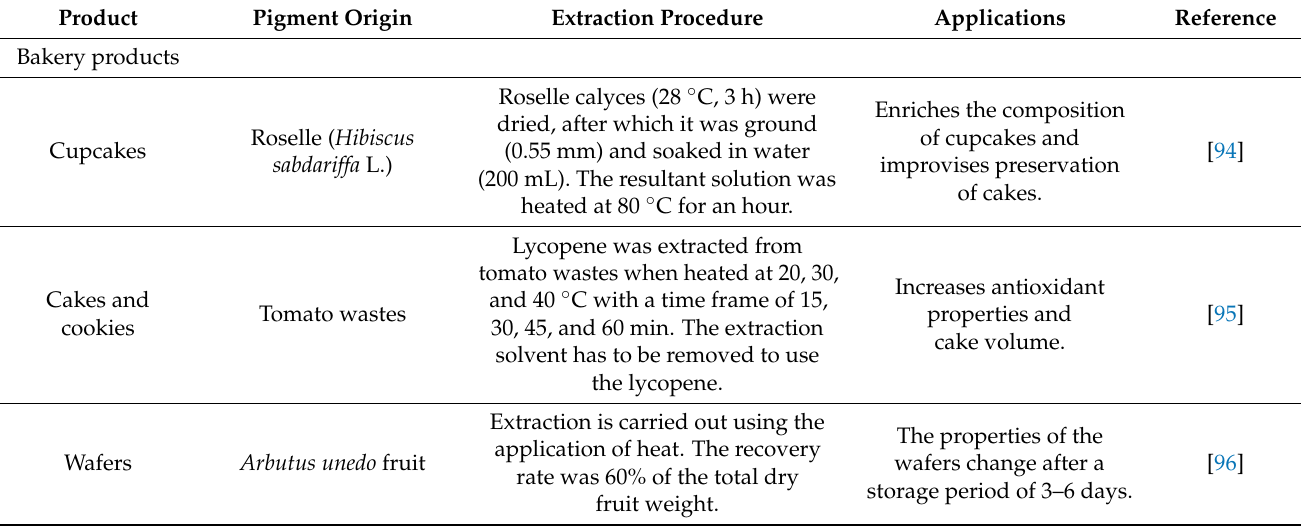
Table 3. Applications of natural food colorants, their sources, and extraction